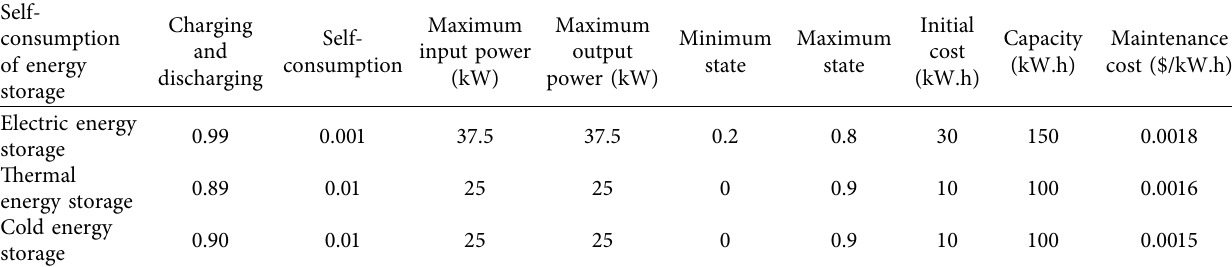
Table 2: Energy storage unit parameters.